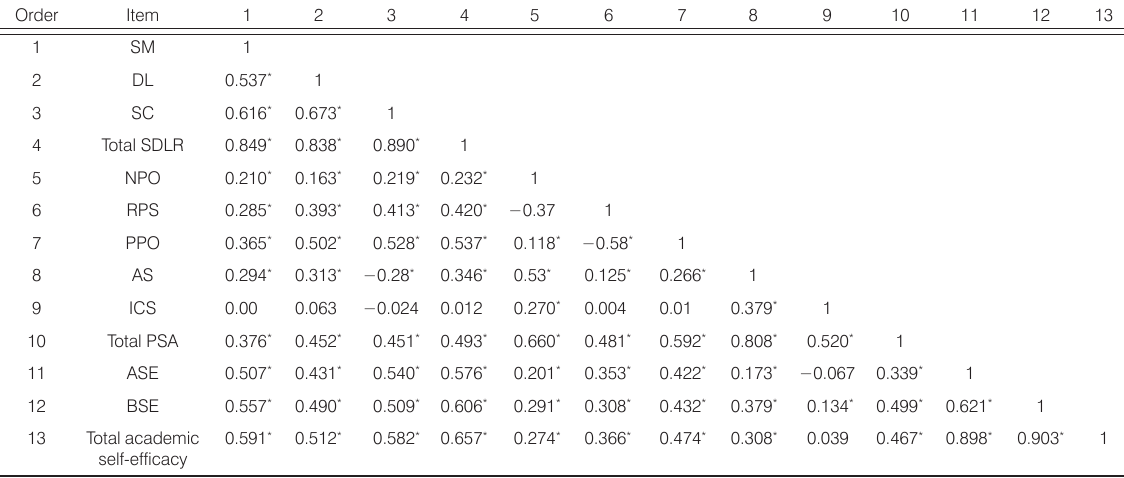
Table 2. Pearson correlation coefficients of the variables (N =